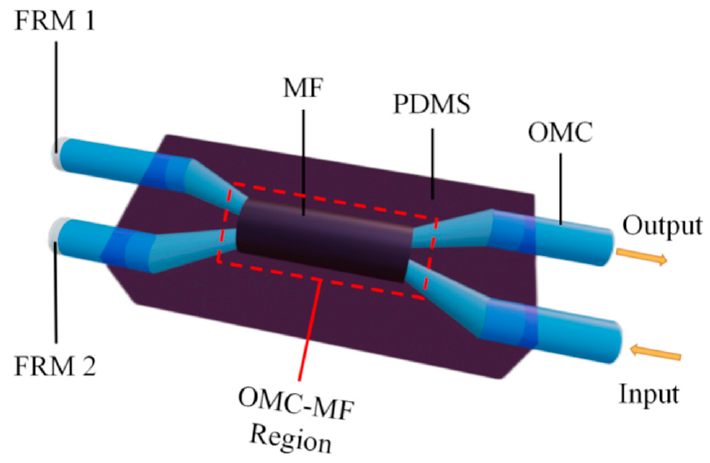
Figure 2. The structure of the sensor.